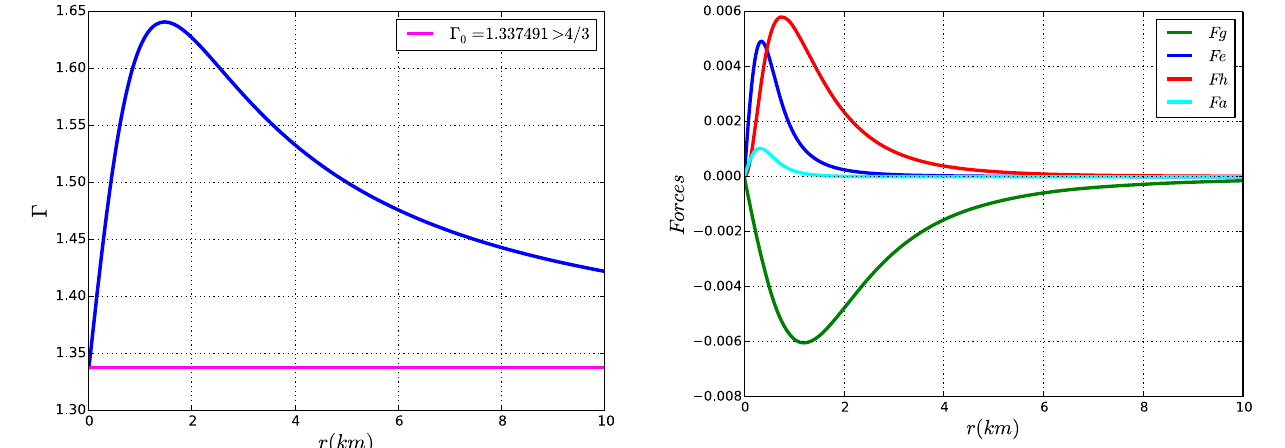
Fig. 12 Adiabatic index Γ against radial distance r [35,84,85], where M g = r 2 v